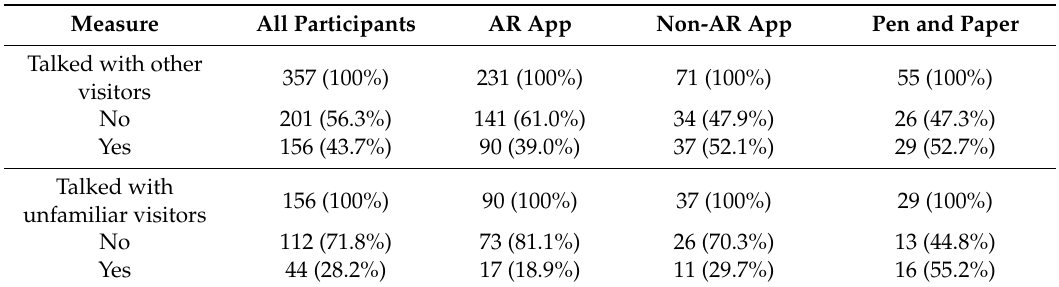
Table 3. Cross Tabulation of Talking with Other Visitors by Experimental Groups ( N =